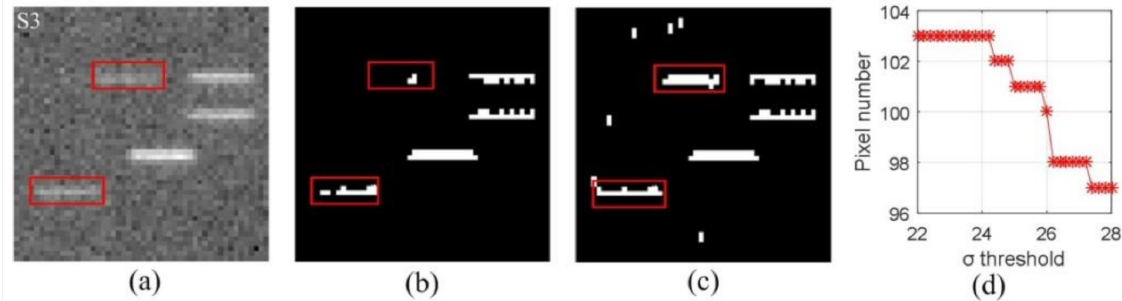
Figure 7. Recognition results of extended objects. ( a ) Original image. ( b ) GS method (th1 = 37.67). ( c ) SDS method (th2 = 24.11). ( d ) Recognized pixel number of the five objects in different σ thresholdings.